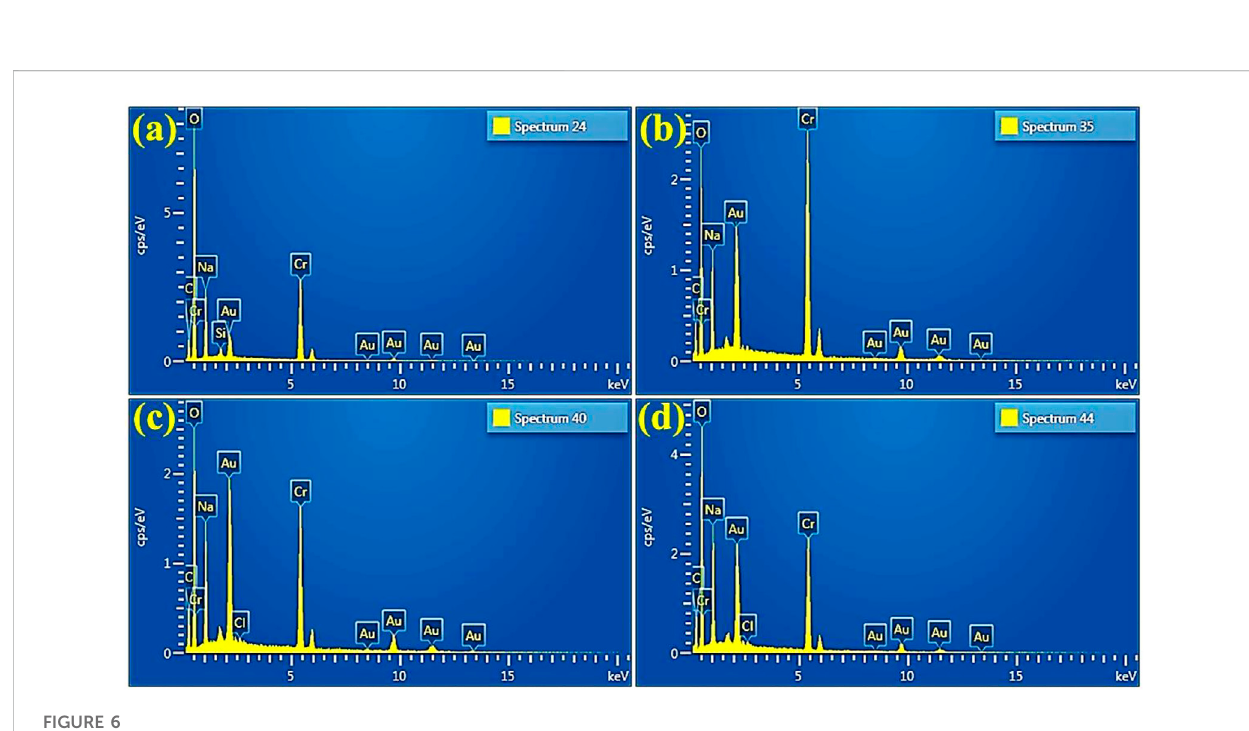
FIGURE 6 EDS of (A) Cr 2 O 3 (B) 2% Sr/Cr 2 O 3 (C) 4% Sr/Cr 2 O 3 (D) 6% Sr/Cr 2 O 3